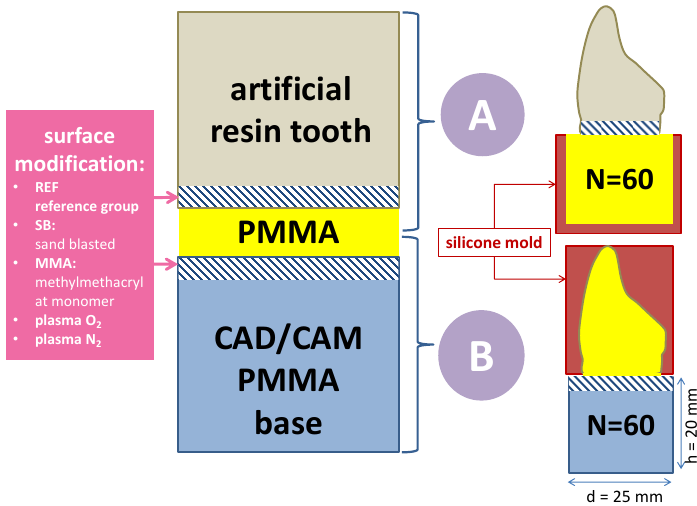
Figure 1. Schematic drawing of the interface and experimental conditioned surfaces towards the bonding interface by polymerizing PMMA (powder + liquid system). Consequently, two groups of specimens ( n = 60 per group) are subdivided per surface modification ( n = 12 per subgroup).